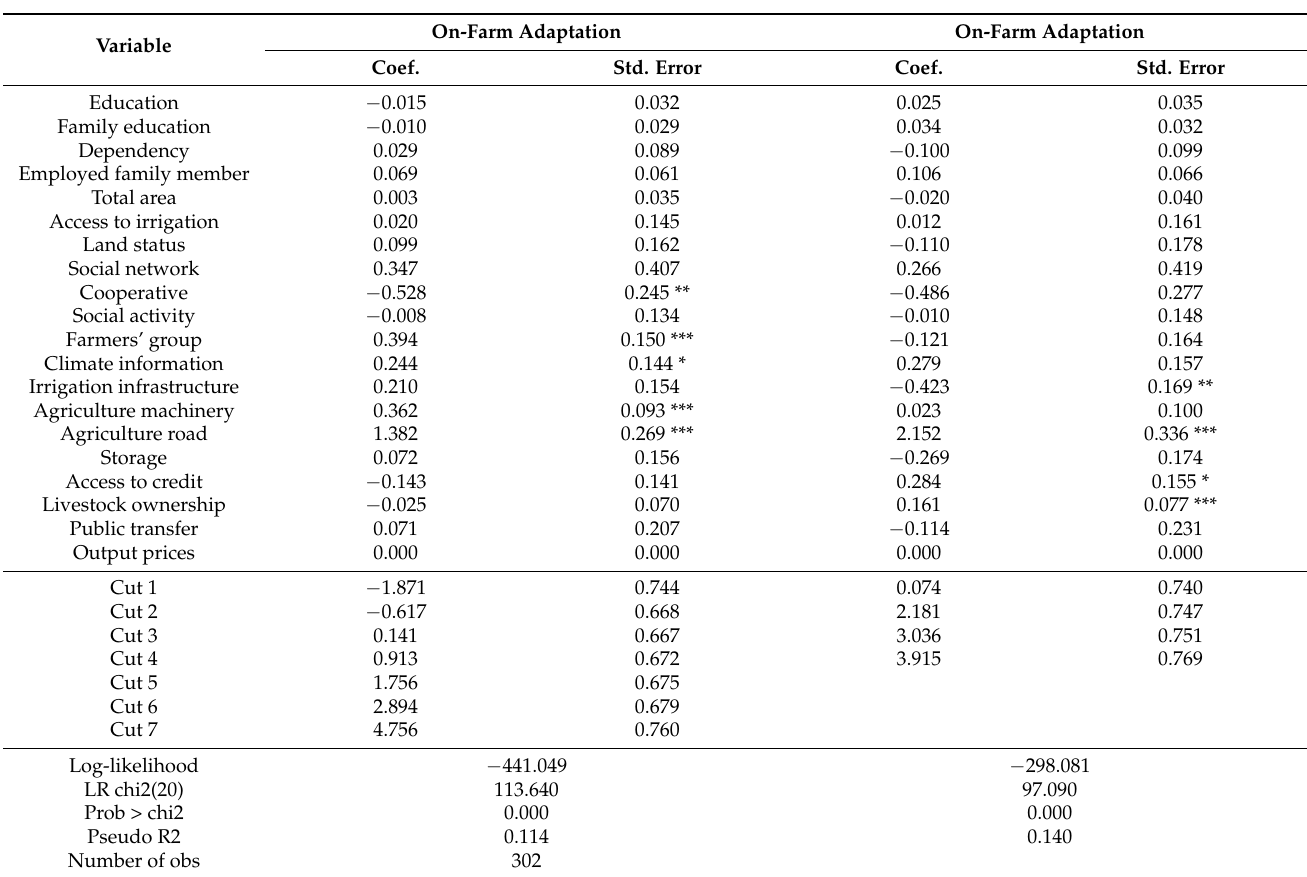
Table 3. The determinant of adaptation